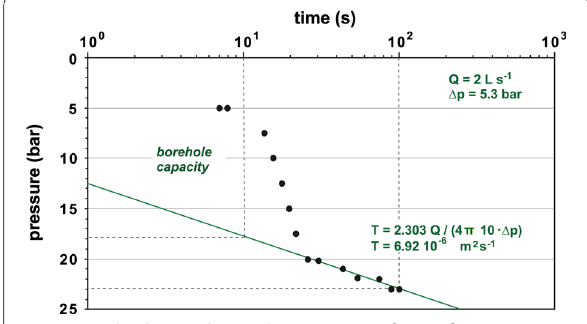
Fig. 12 Hydraulic test data and interpretation from inflow point